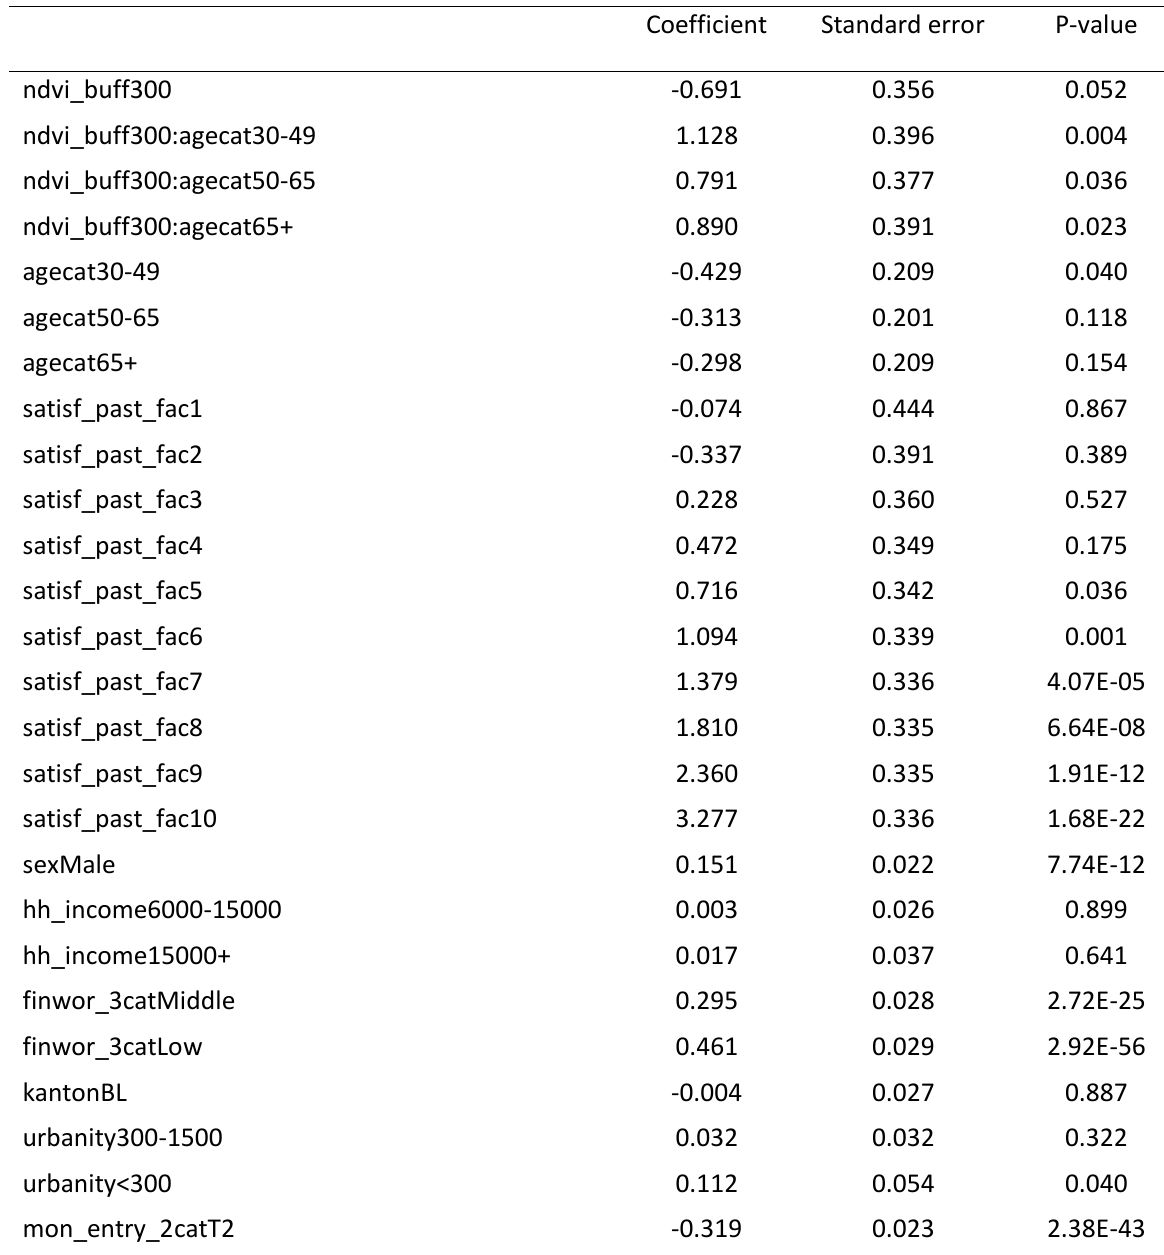
Table S5 . Results from ordered probit regression of life satisfaction on NDVI (a) by age categories, (b) by household income, (c) by financial worries, adjusted for life satisfaction in the past, age categories, sex, household income, financial worries, canton, degree of urbanisation, and month of entry (a) Moderation by age